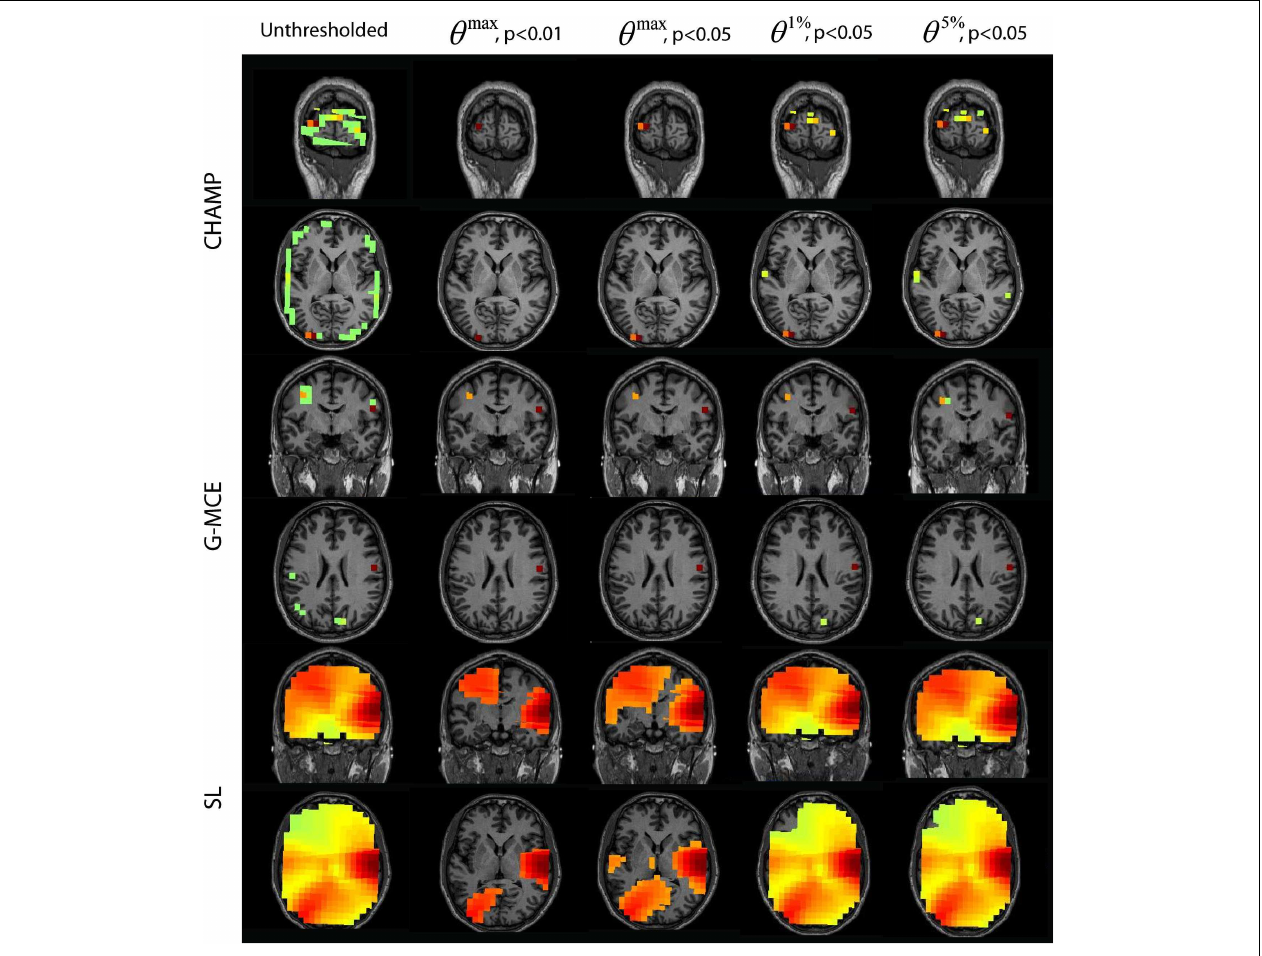
power is thresholded with the maximal statistic: θ max , p < 0.01 and 0.05 and with the alternative to the maximal statistic thresholds: θ 1% , p < 0.05, and θ 5% , p <